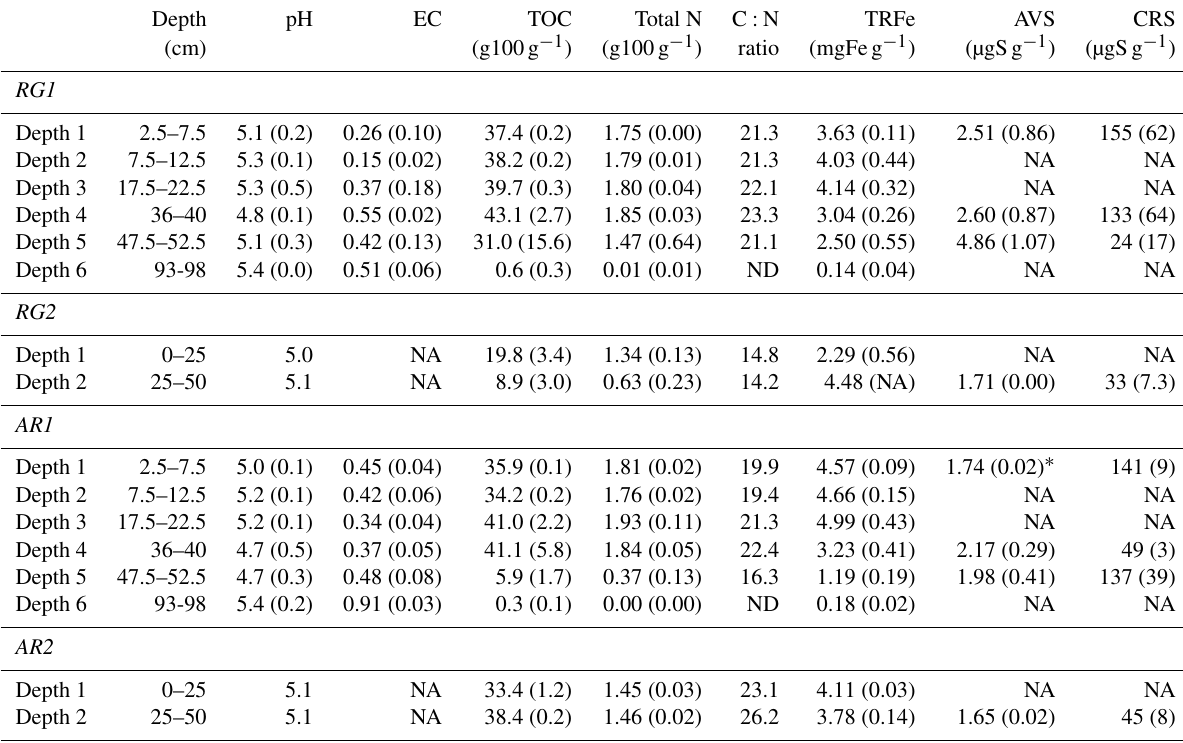
Table 1. Selected characteristics of soil profiles at the four monitoring sites with rotational grass ( RG1 and RG2 ) and potato crop ( AR1 and AR2 ). All analyses were done in triplicate; results shown represent mean and standard error of two soil profiles for which a complete data set was available. Soils for analyses were collected in late April (DOY 113) except for AVS and CRS (early September). Abbreviations: EC – electrical conductivity, TOC – total soil organic carbon, TRFe – total reactive iron, AVS – acid-volatile sulfide – and CRS – chromium- reducible